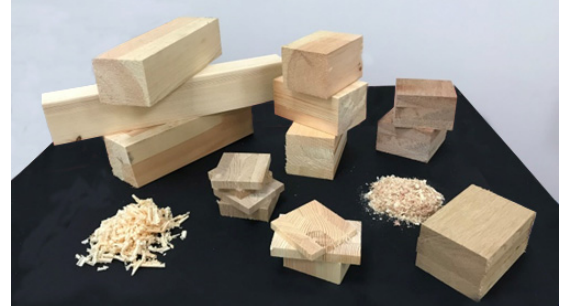
Figure 1. Wood waste